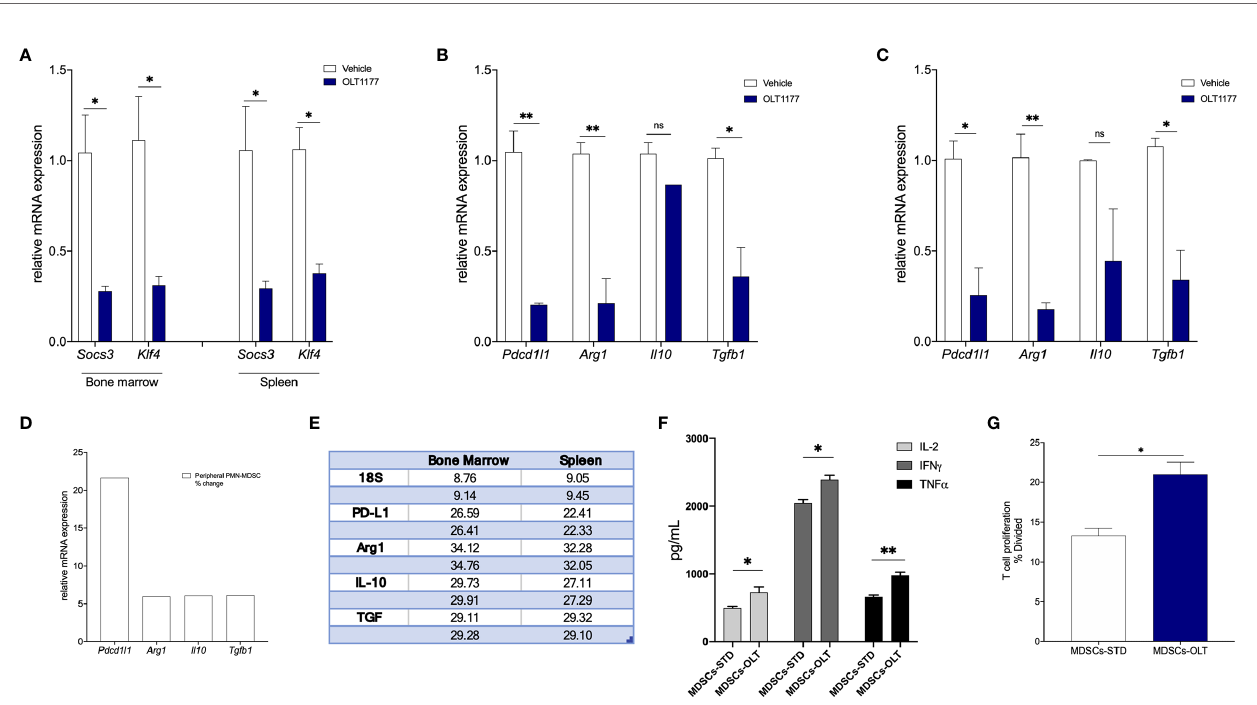
FIGURE 4 | pSTAT3(Y705) regulates PMN-MDSCs immunosuppressive gene expression. Mice were implanted with B16F10 and treated with saline control (Vehicle) or OLT1177 (OLT1177), on day 15 PMN-MDSCs were isolated from bone marrow and spleen. (A) Mean ± SEM of relative mRNA expression of Socs3 and Klf4 from PMN- MDSCs isolated from bone marrow or spleen of tumor-bearing mice described above (N=2, pooled from 4 mice/group. 2 independent experiments). (B) Mean ± SEM of relative mRNA expression of Pdcd1l1 , Arg1, Il10 and Tgfb1 from PMN-MDSCs isolated from bone marrow of mice described above (N=2, pooled from 4 mice/group. 2 independent experiments). (C) Mean ± SEM of relative mRNA expression of Pdcd1l1 , Arg1, Il10 and Tgfb1 from PMN-MDSCs isolated from spleen of mice described above (N=2, pooled from 4 mice/group. 2 independent experiments). (D) Fold change of relative mRNA expression of Pdcd1l1 , Arg1, Il10 and Tgfb1 from PMN-MDSCs isolated from spleen compared to PMN-MDSCs isolated from bone marrow. (E) Cq values (in duplicate) depicting raw rtPCR data described in (D) . (E) Co-culture of naïve CD8+ T cells with MDSCs isolated from tumor-bearing mice treated with saline control (Vehicle) or OLT1177 (OLT1177). (F) Mean ± SEM for IL-2, IFN g and TNF a production from co-culture described in (E) (N=3). (G) T cell proliferation from co-culture described in (F) (N=3). ns (not signi fi cant), * p < 0.05, ** p <